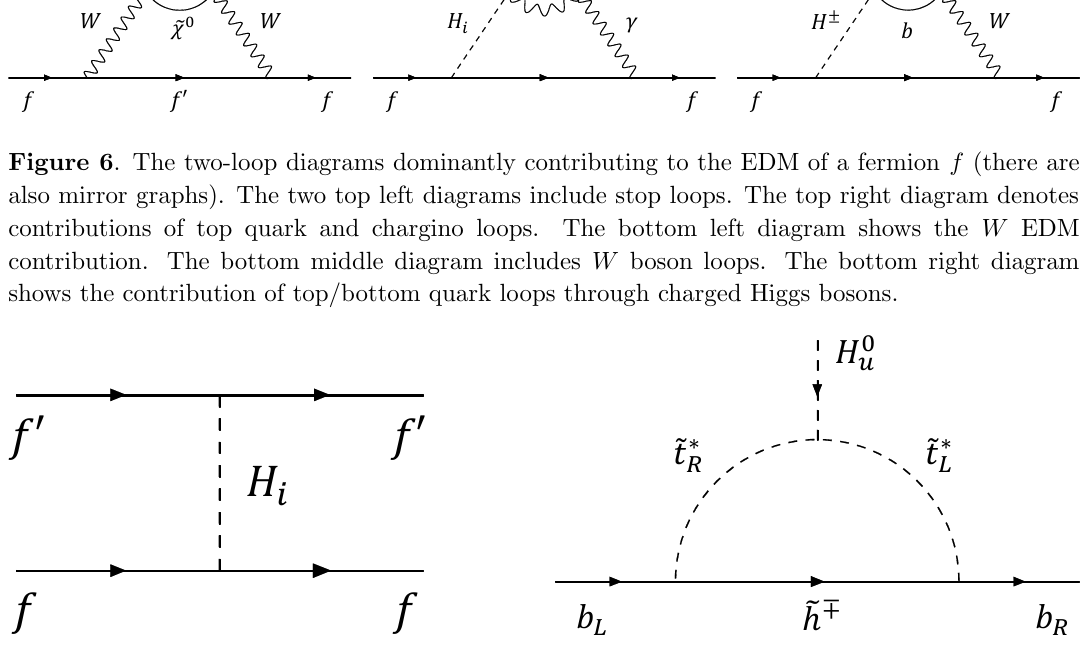
Figure 7 . The CP-odd four fermion operators induced by the tree-level Higgs boson exchange (left). Without new CP phases beyond the MSSM, the four fermion operators come from the wrong-Higgs Yukawa coupling of bottom quarks induced by a stop/higgsino loop